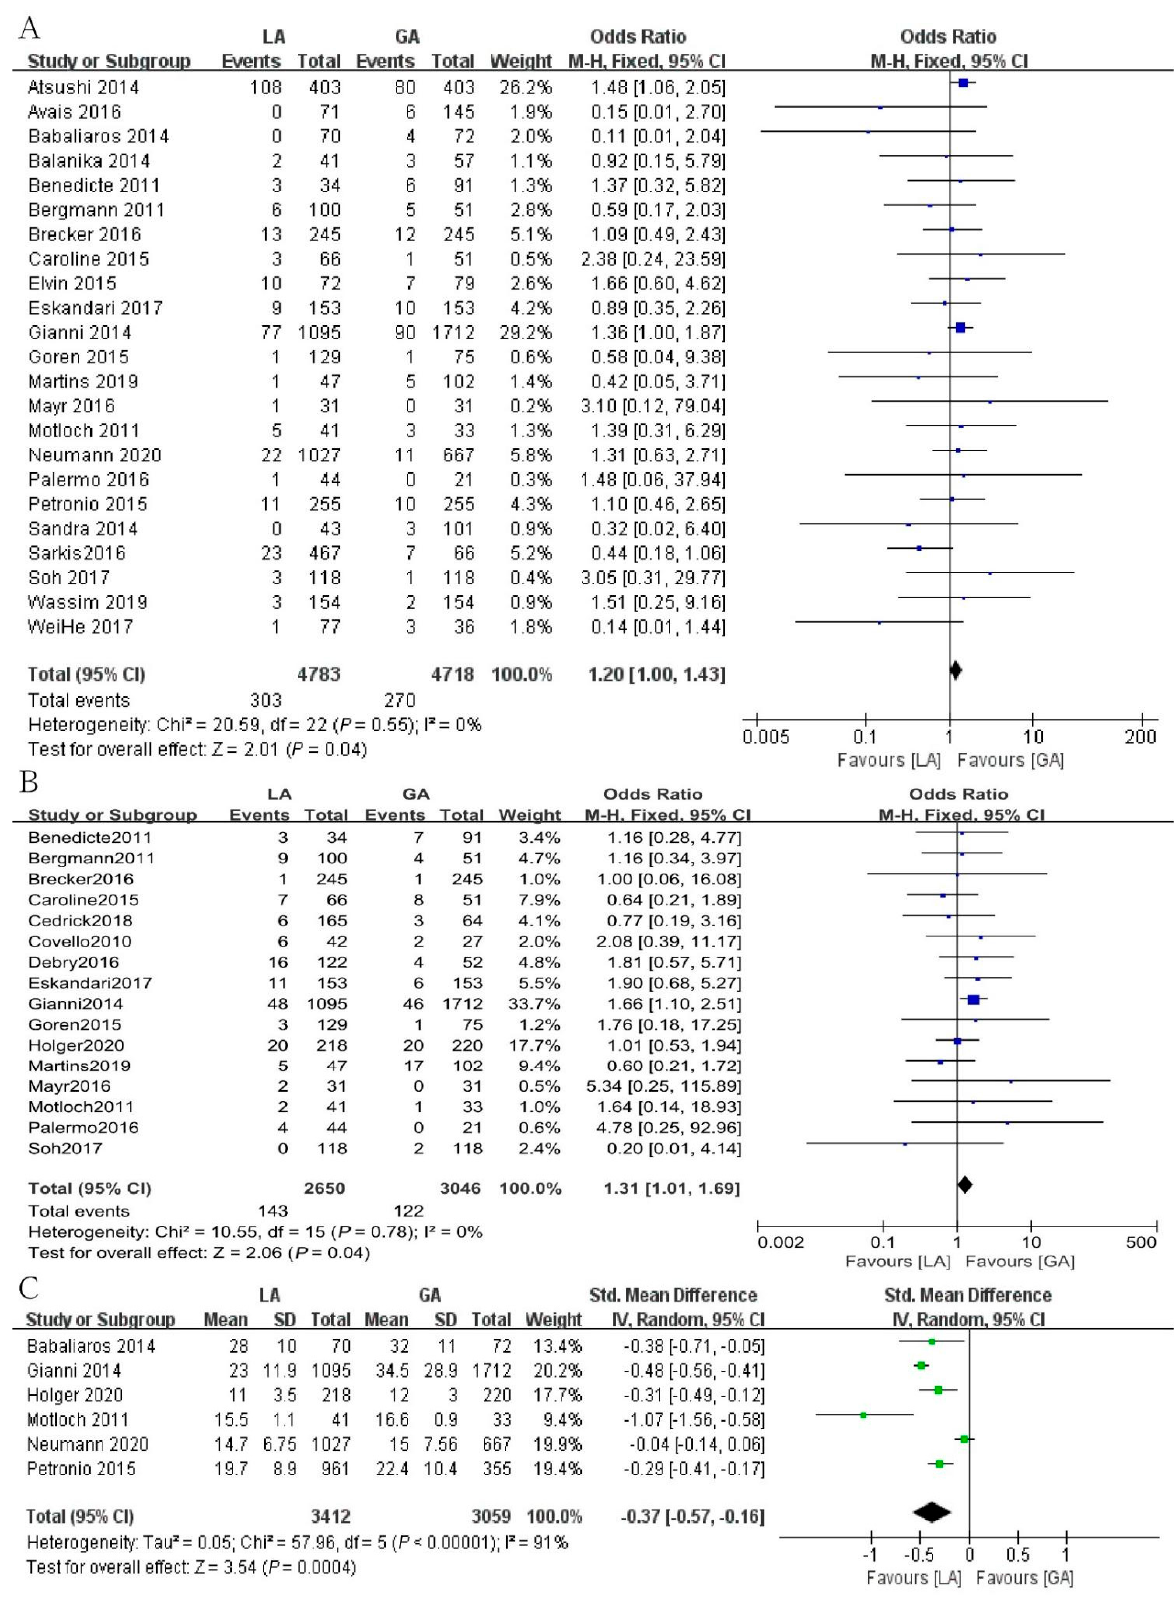
Figure 4. Forest plot of ( A ) 30-day mortality. ( B ) The incidence of acute kidney injury. ( C ) The fluoroscopy time. Green symbols: continuous data; blue symbols: dichotomous data; black symbols: other type data.